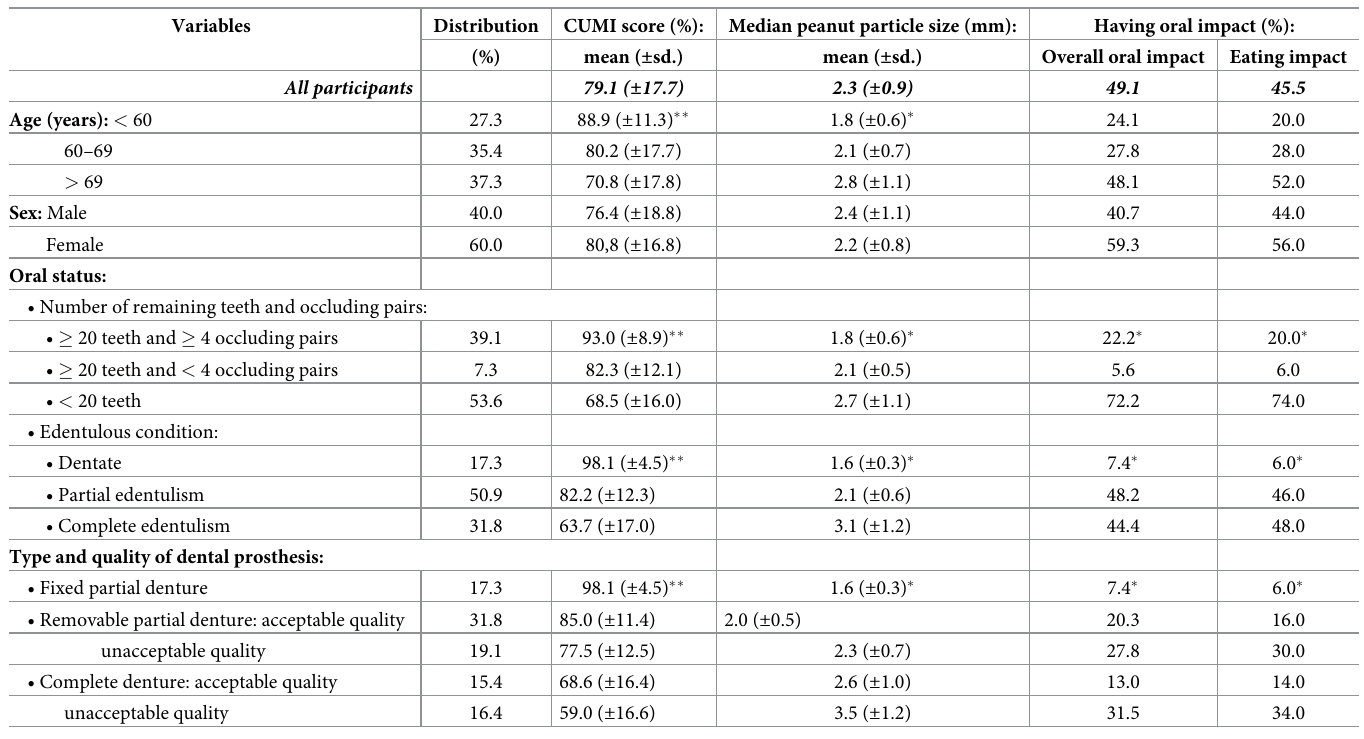
Table 2. Masticatory ability of the